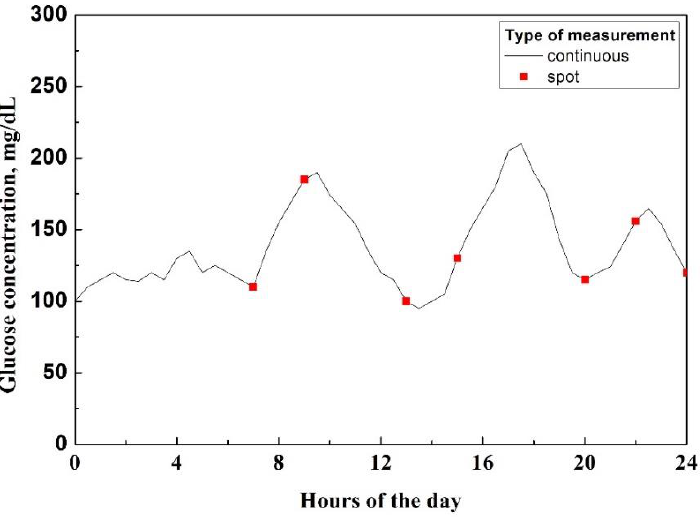
Figure 4. Comparison of type 1-diabetes continuous monitoring and spot-like monitoring.